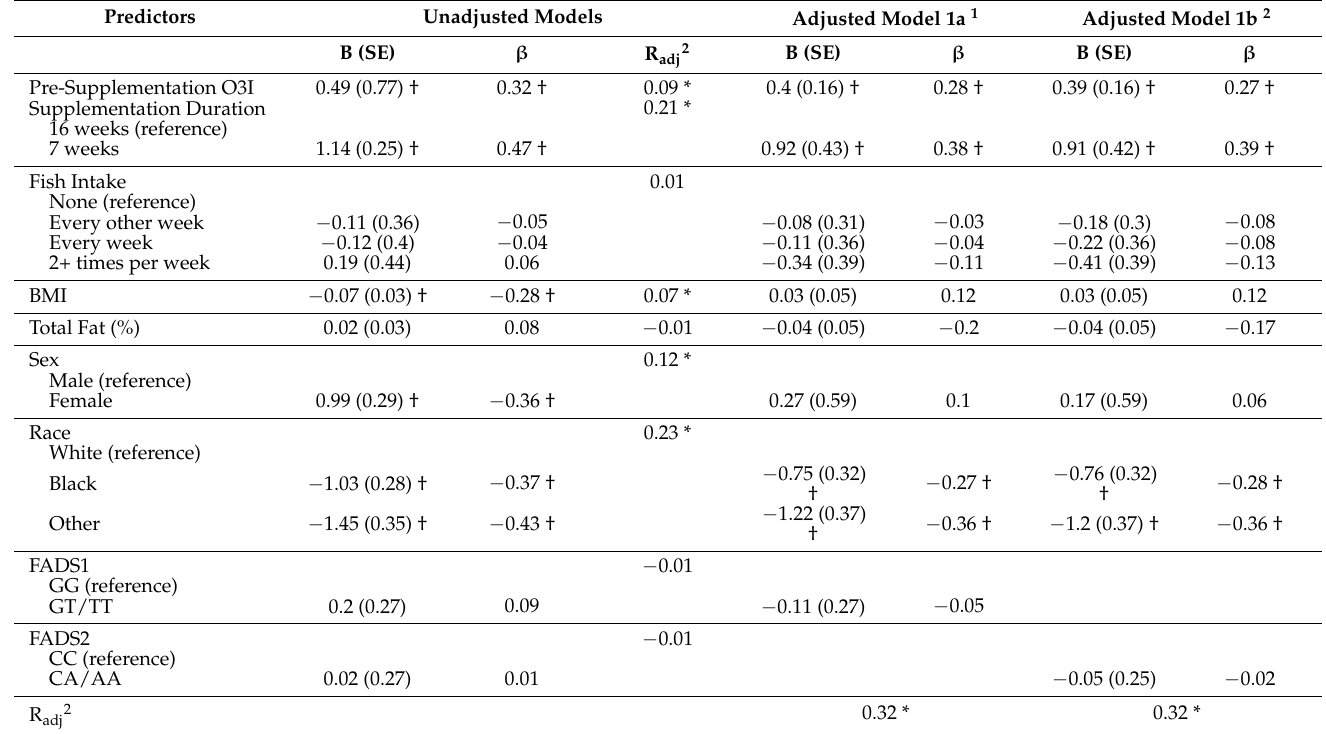
Table 3. Unadjusted beta and standardized beta coefficients ( β ) and adjusted regression models predicting post-supplementation